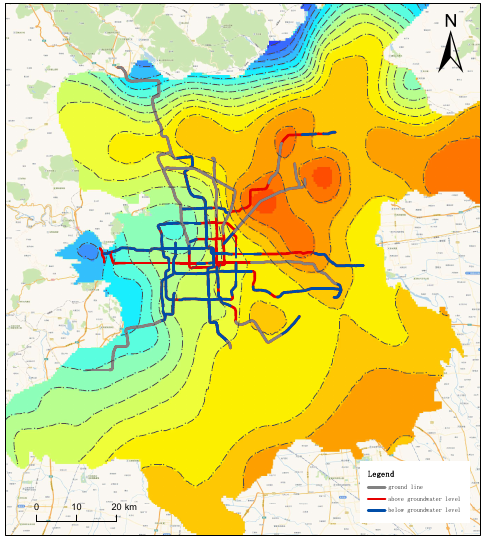
Figure 6 . The relationship between the groundwater level and the vertical position of the subway.